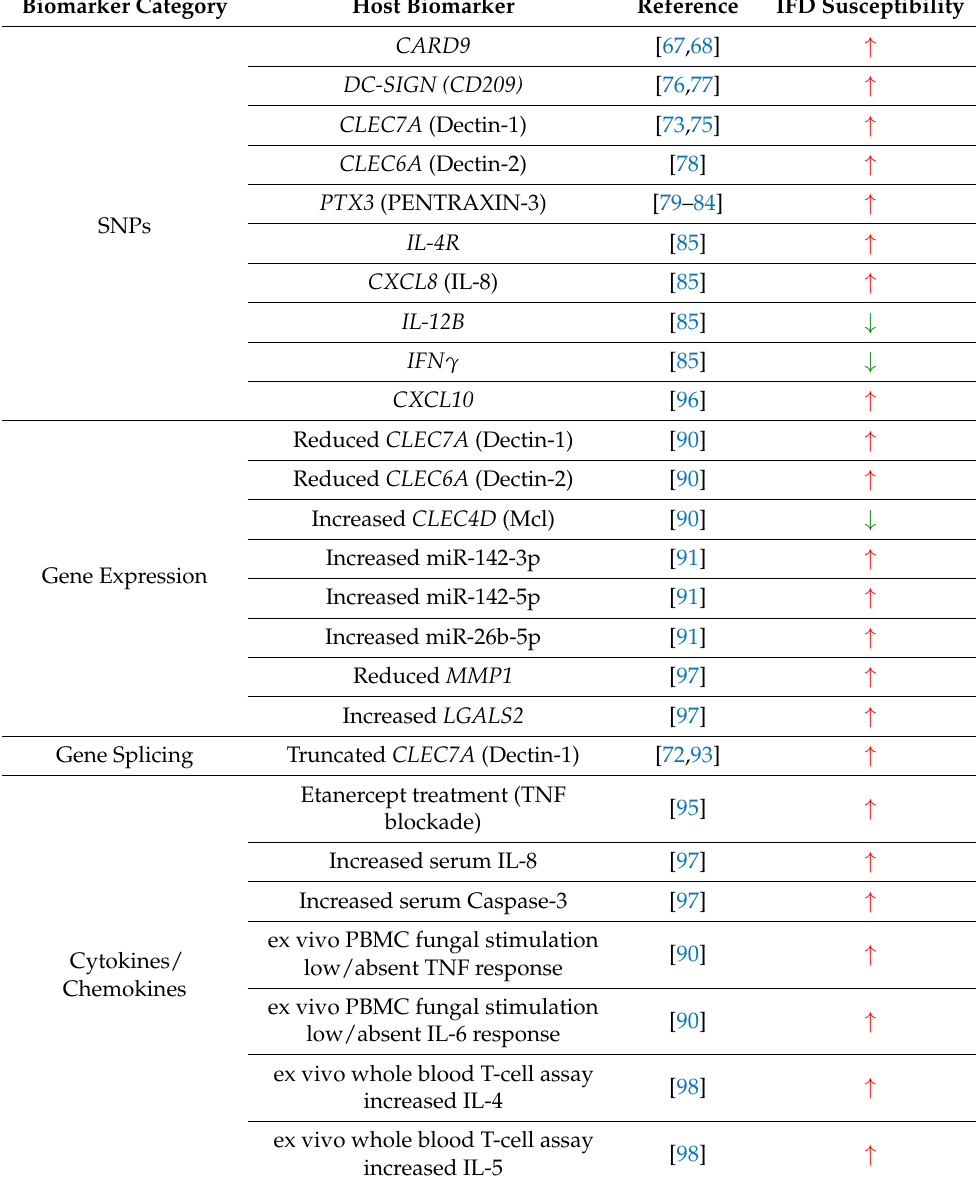
Key: Red up arrows indicate increased IFD risk. Green down arrows indicate reduced IFD